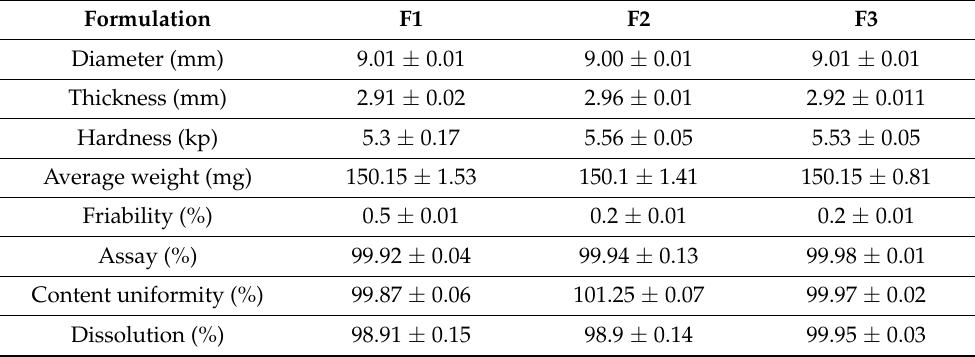
Table 3. Characterization of the post-compression core tablets (F1 to F3).